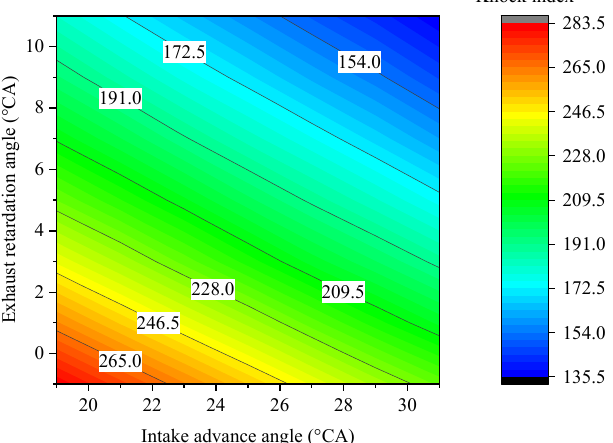
Figure 21. Knock index versus the combined change of intake advance angle and exhaust retardation angle (point of operation: n = 3000 rpm, BMEP = 10 bar, ignition timing = 18.75 °CA BTDC (Before Top Dead Center)).